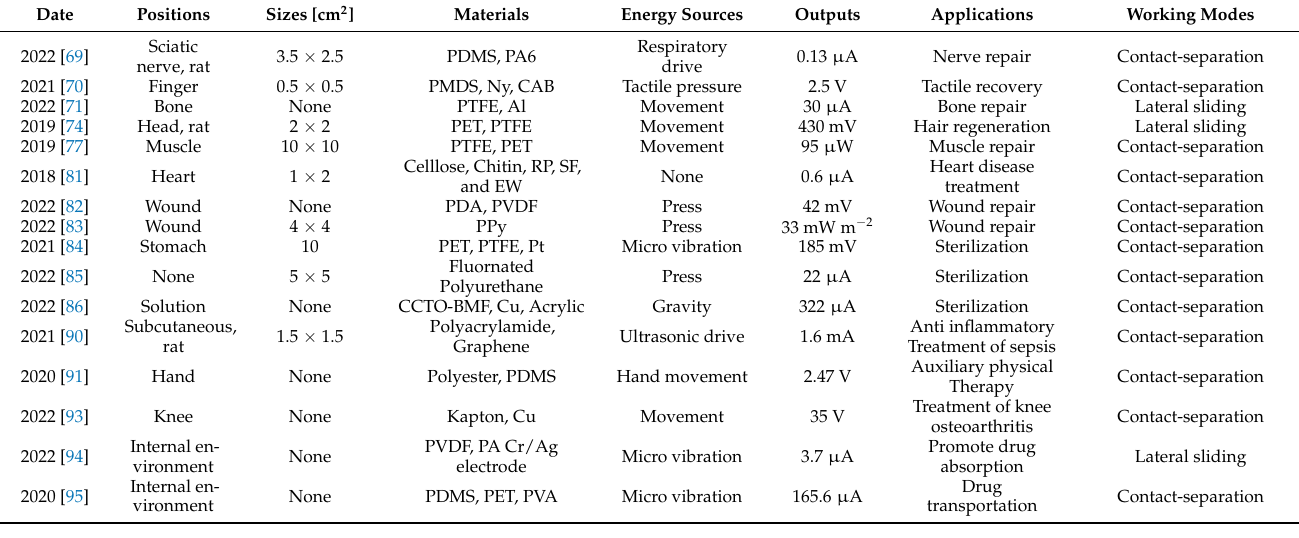
Table 3. Summar of TENG treatment parameters.